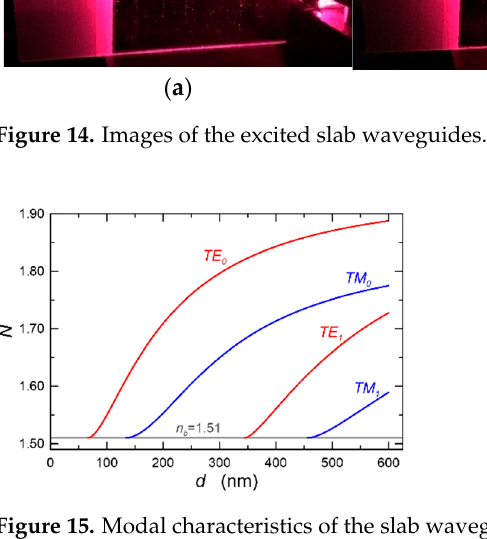
Figure 15. Modal characteristics of the slab waveguide. n b -n 1 -n c = 1.51-1.94-1.00, λ = 677 nm.